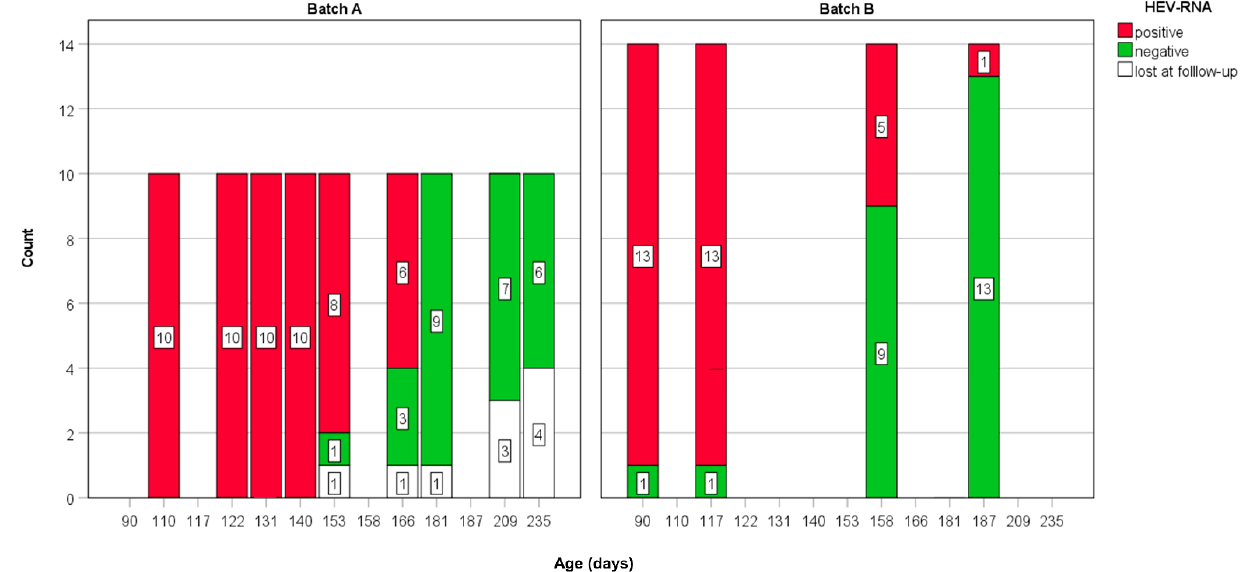
Figure 1. Scheme summary of HEV-RNA detection for each batch over the study period. Animals lost during the study are indicated in white (lost at follow-up because died or lost the ear-tag). 2.2. RNA Extraction and Quantitative Real-Time Reverse Transcription